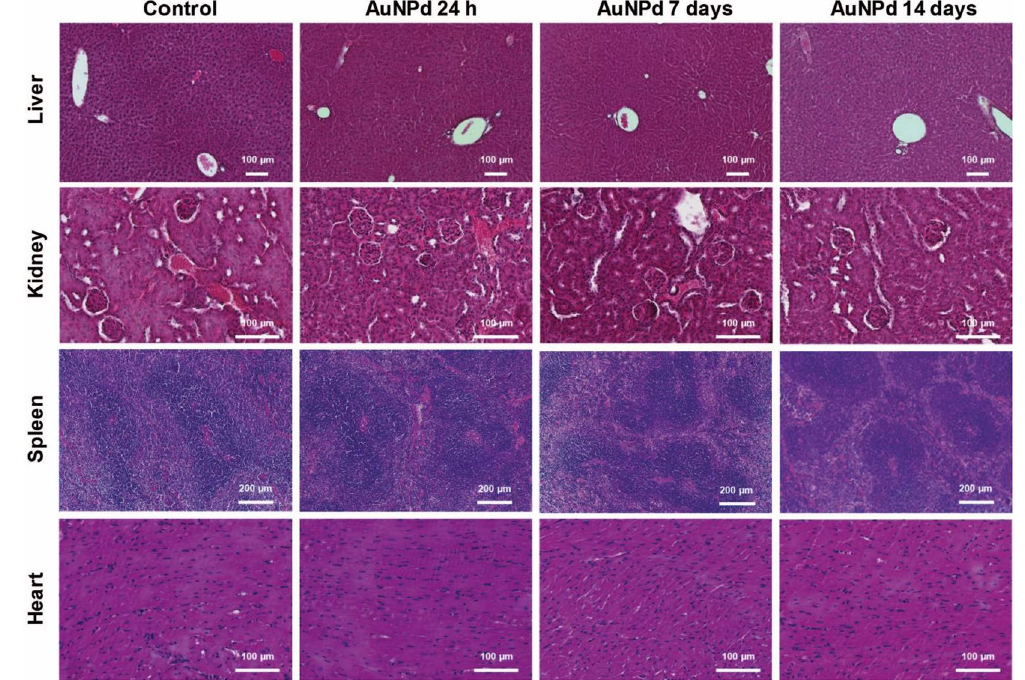
Figure 5. Histological section of mice liver, kidney, spleen and heart, 24 h, 7 and 14 days after intravenous administration of AuNPd (1 mg/kg) compared to the control group administered with vehicle alone. All sections were stained with